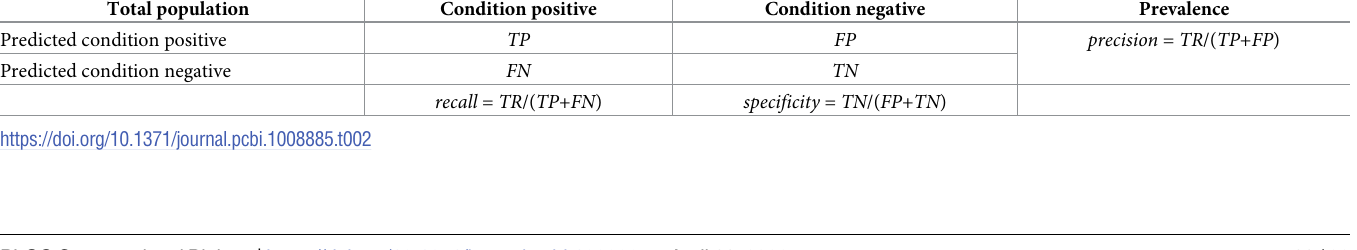
Table 2. Contingency table for calculating the receiver operating characteristic curve. Total